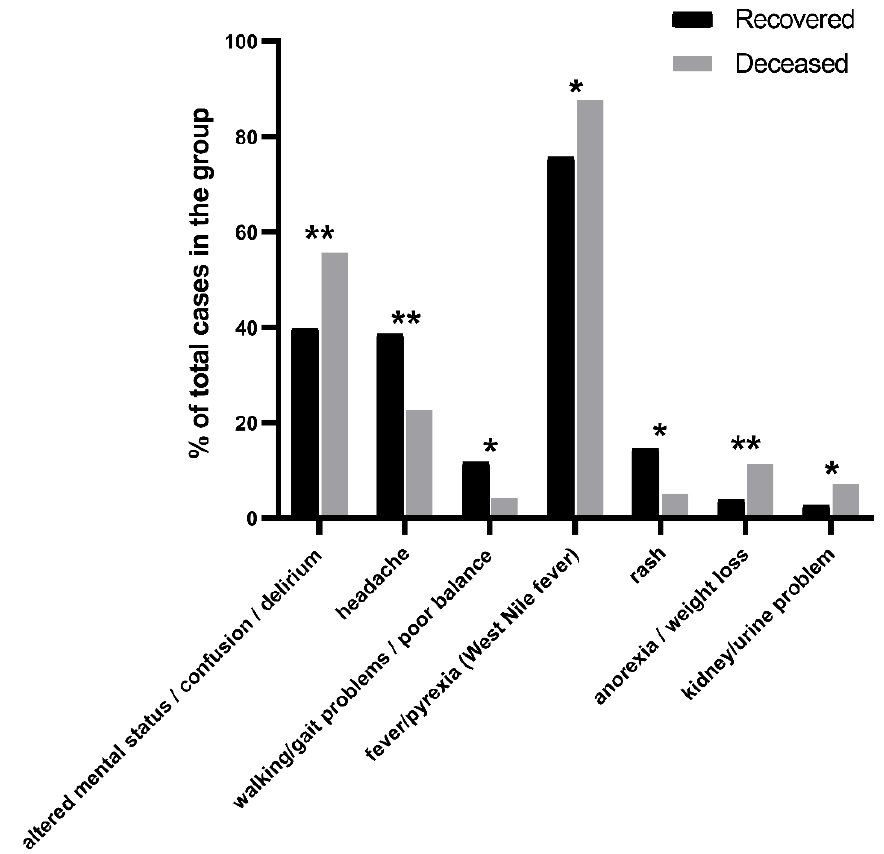
Figure 2. Rates of occurrence for the majority of symptoms related to WNV infection between patients that recovered and those that deceased. Significant differences for each symptom between the recovered and deceased groups of patients were assessed by a two-tailed t -test (two-sample assuming equal variances) and are indicated by (* p < 0.05 and ** p < 0.01).